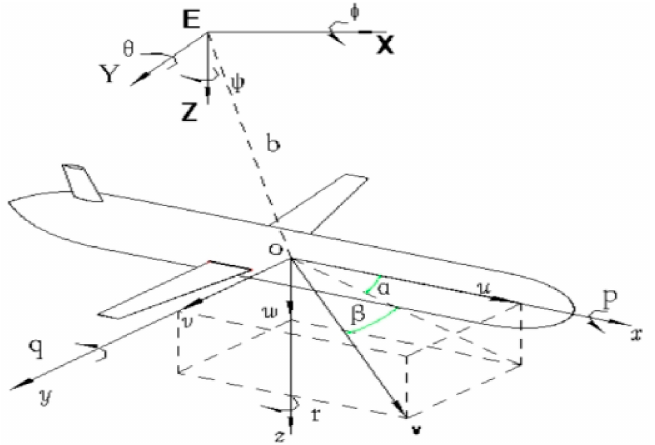
Figure 4. Motion reference